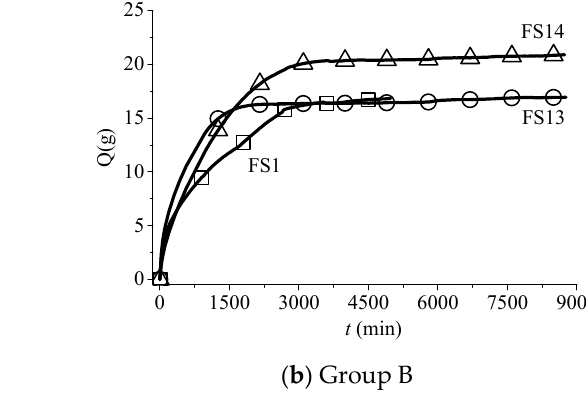
Figure 7. Relationship between water imbibition and time.